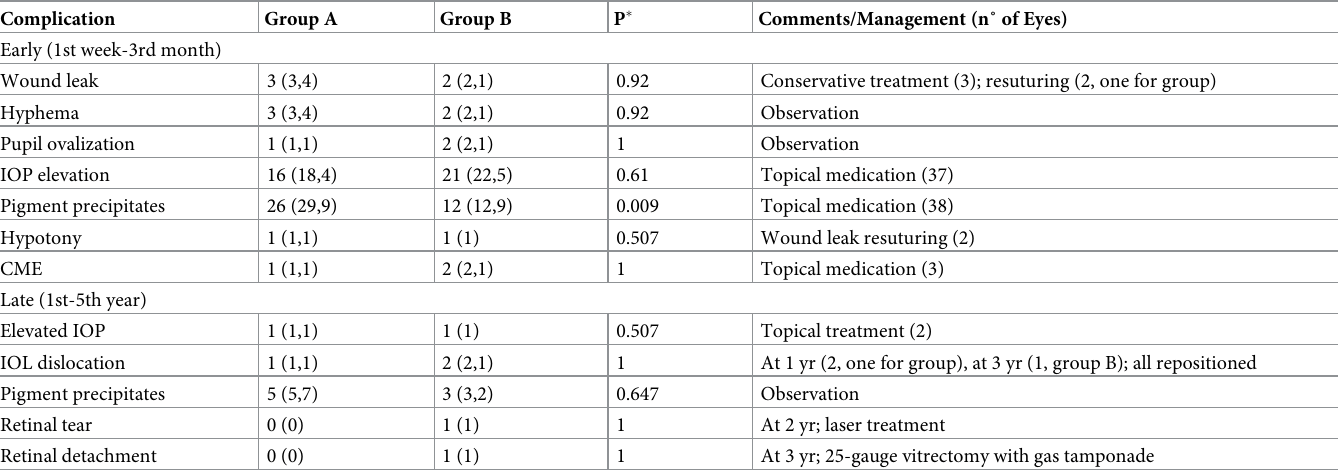
Table 5. Postoperative complications for Group A (anterior chamber iris-claw fixation) and Group B (retropupillary iris-claw